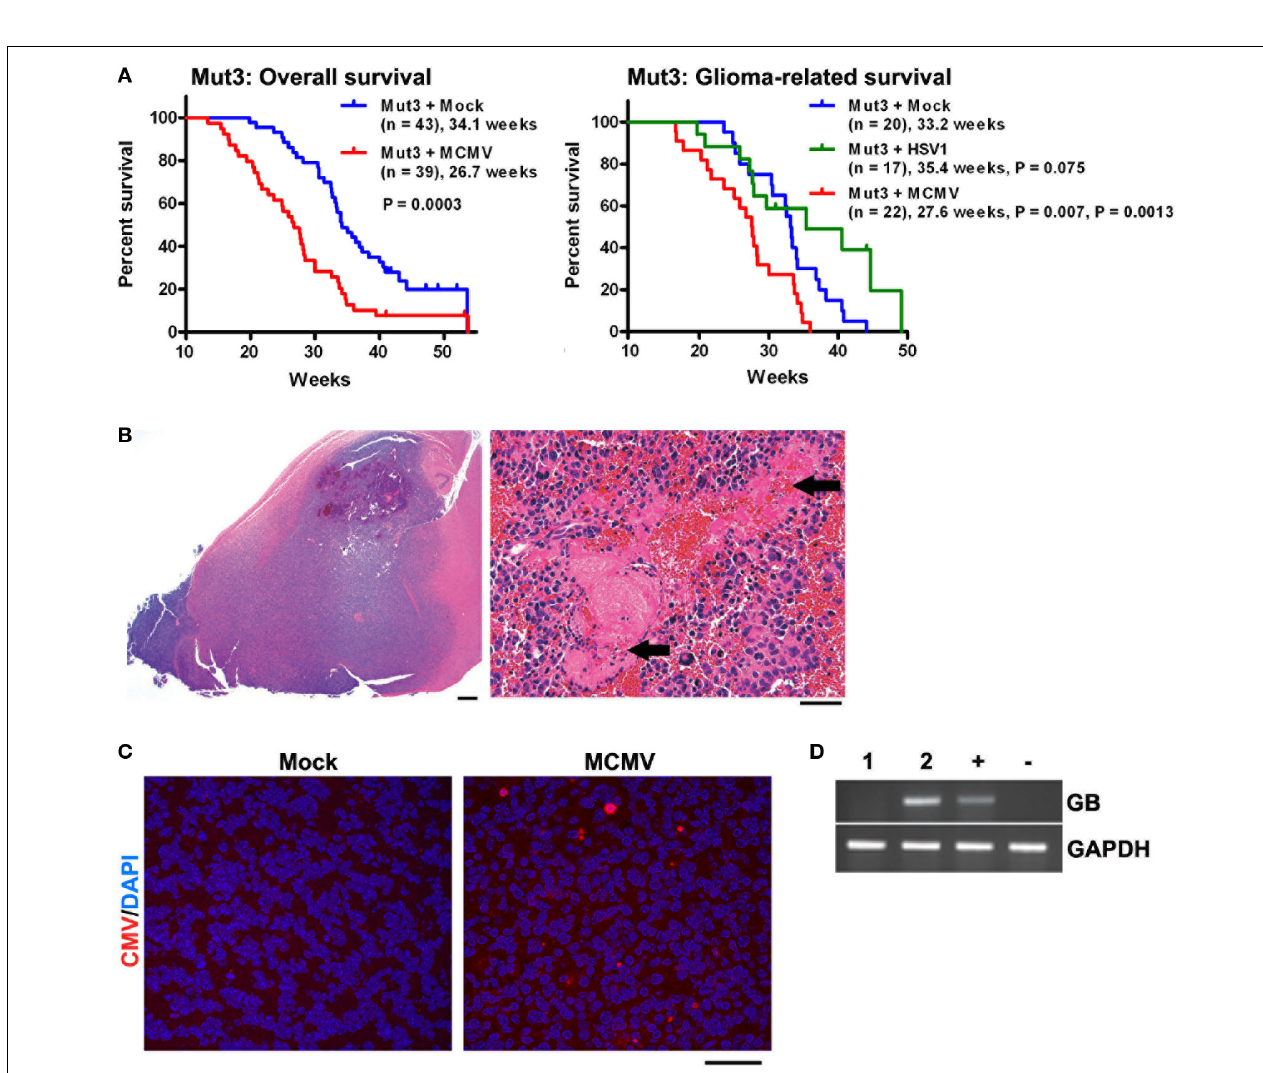
forebrain. Scale bar = 500mm. Right, a higher magnification image from the same tumor displaying extensive necrosis (arrows). Scale bar = 50mm. (C) IHC gliomas from mock- (i) versus MCMV-infected (ii) Mut3 mice. “ + ” and “ (cid:0) ”: MCMV-infected and -negative cells, respectively. Reprinted by permission